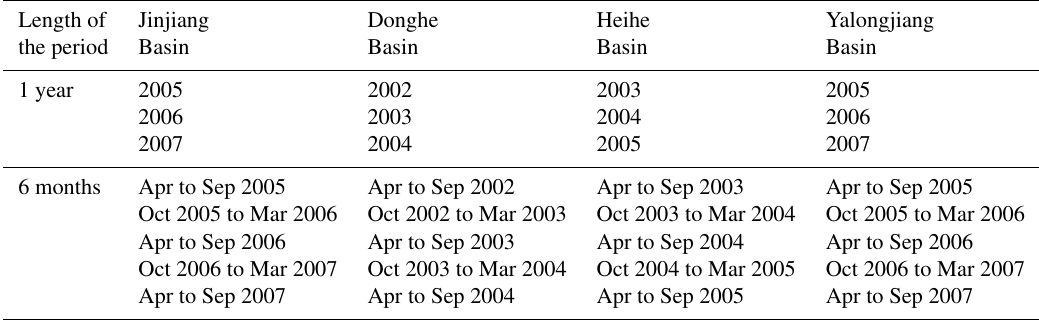
Table 3. Short periods for which corresponding data were used for the calibrations at stage one of the evaluation. Length of Jinjiang Donghe Heihe Yalongjiang the period Basin Basin Basin